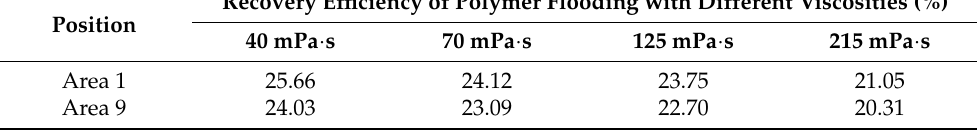
Table 5. Variations in recovery in the microscopic unaffected